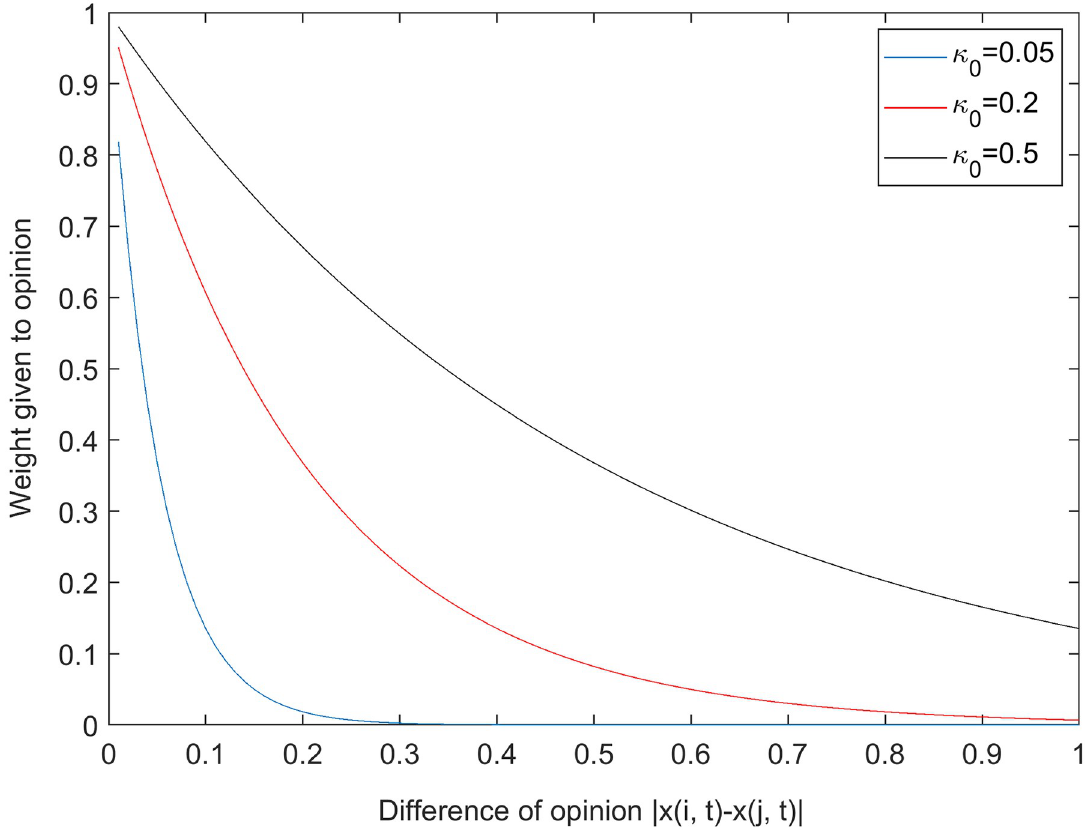
on the weighting of opinion. The relative weight a grower i gives to an opinion of grower j as a O